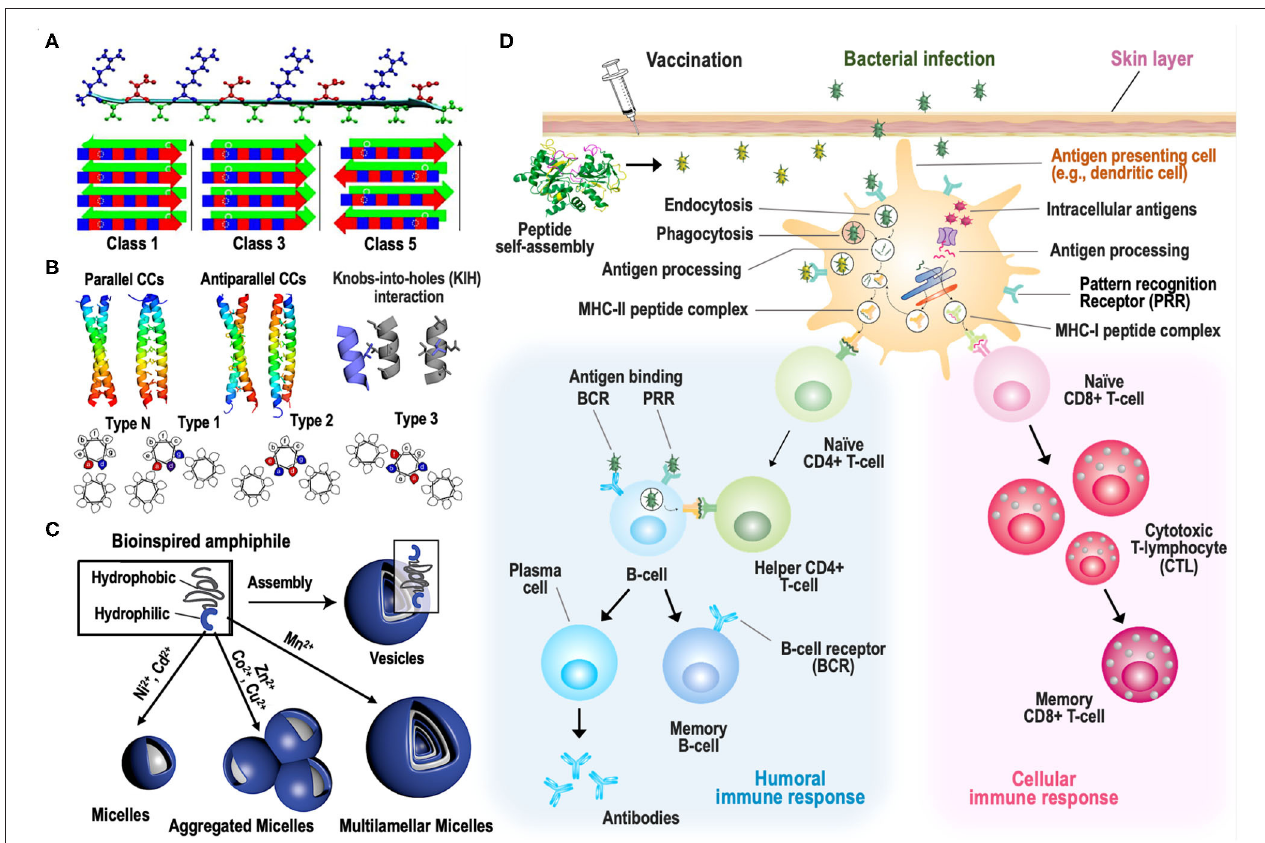
FIGURE 1 | Strategies to induce supramolecular self-assembly of peptides and peptide-based vaccines. (A) Formation of β -strands from self-assembling peptide RADA16-I (top) and their arrangement into nanofibers with different symmetry classes arranged into stacks of two β -sheets (bottom). β -sheets are formed by alternating segments of hydrophobic alanine (green) and hydrophilic arginine/aspartate (blue/red) regions (reproduced with permission from Cormier et al., 2013). (B) Symmetry (top) and sequence (bottom) of coiled-coils (CCs) made of peptides containing a heptad repeat of hydrophobic (h) and polar (p) residues in a hpphppp pattern. Helical wheels for classical Type-N, and Type-1, Type-2, and Type-3 interfaces are depicted. All are viewed along the α -helices from the N to C termini, labels are for the canonical a–g nomenclature and the teardrop shapes indicate the direction of C α -C β bonds (reproduced with permission from Rhys et al., 2018). (C) Effect of different divalent transition metal ions on the morphological transformation of self-assembled PAs, consisting of hexahistidine as a hydrophilic head and oligostyrene as a hydrophobic tail (reproduced from Knight et al., 2018). (D) Schematic illustration of immune stimulation by self-assembled peptide-based vaccines. Peptides undergo self-assembly upon intra-muscular or subcutaneous vaccination, after which they can induce humoral and/or cellular immune responses to protect individuals against pathogens. Humoral immune responses arise once B-cells encounter antigens in secondary lymphoid organs, inducing their activation. Mechanistically, B-cell activation occurs upon binding of antigens to the B-cell receptor (BCR), resulting in the internalization of antigens via receptor-mediated endocytosis. These antigens are then processed, and antigenic peptide-loaded MHC II is displayed on the cell surface, allowing CD4 + helper T-cell binding. CD4 + helper T-cells further stimulate B-cells to undergo proliferation, immunoglobulin (Ig) class-switching, and differentiation into antigen-specific antibody-secreting plasma cells and memory B-cells. To induce CTL-mediated cellular immune responses, antigens need to be processed and presented by antigen-presenting cells (APCs), such as dendritic cells and macrophages. APCs take up the antigen by pinocytosis, phagocytosis, and receptor-mediated phagocytosis, cleave the antigen into smaller peptide fragments, and present these peptides on MHC. In the lymph nodes, extracellular antigenic peptides are presented on MHC II to CD4 + T-cells, whereas intracellular proteins, including viral and tumor-associated antigens, are presented on MHC I to CD8 + T-cells. A subset of APCs can also present extracellular antigenic peptides on MHC I in a process known as cross-presentation. Once activated, naïve CD8 + T-cells proliferate into CTLs to mediate antigen-specific cytotoxicity. A fraction of CD8 + T-cells become memory CD8 + T-cells to ensure long-term protection. Upon activation, naïve CD4 + T-cells differentiate into helper T-cells which secrete cytokines to support CTL expansion and survival along with B-cell proliferation and differentiation. Memory B- and T-cells persist in the body for